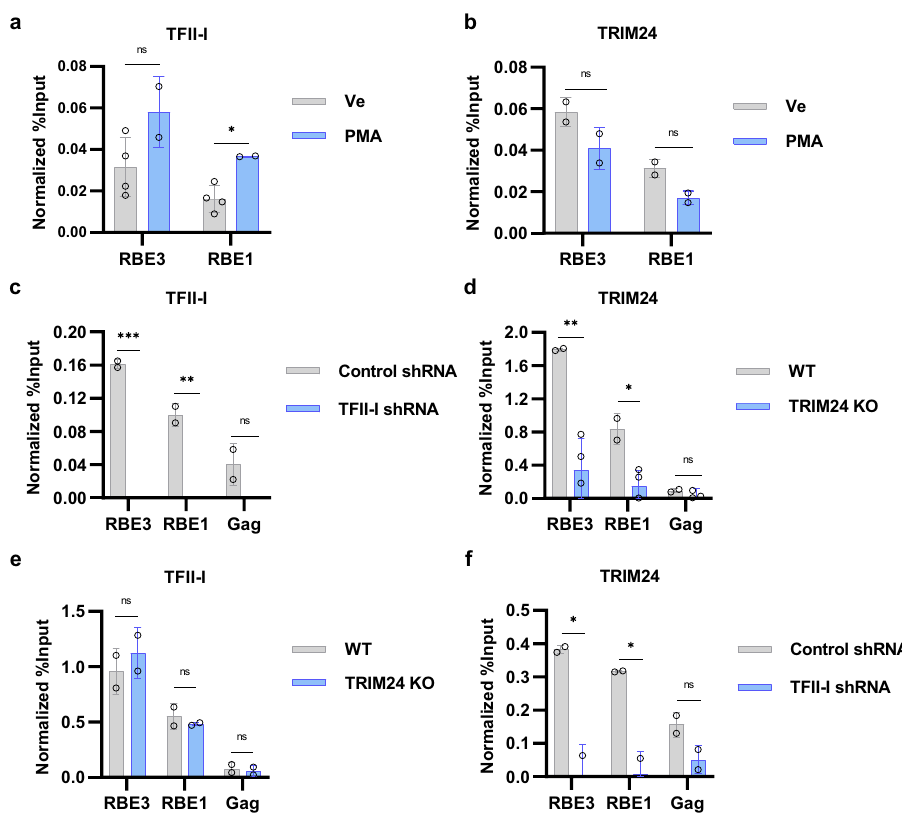
Fig. 6 TFII-I/TRIM24 co-localize to the HIV-1 LTR. a , b Jurkat Tat mdHIV Clone 11 cells were left untreated (Ve, DMSO) or incubated with 50 nM PMA for 24 h. ChIP-qPCR was performed using anti-TFII-I ( a ) or anti-TRIM24 ( b ) antibodies. c ChIP-qPCR analysis was performed using TFII-I antibodies with Jurkat mHIV-Luciferase cells transduced with pLKO lentiviral control shRNA or TFII-I targeting shRNA. d As in ( c ) but anti-TRIM24 antibodies were used for ChIP analysis. e Wild-type or TRIM24 KO Jurkat mHIV-Luciferase cells were subject to ChIP-qPCR analysis using anti-TRIM24 antibodies. f As in ( e ) but anti-TFII-I antibodies were used for ChIP analysis. ChIP-qPCR results are normalized by subtraction of values produced with sample-paired non-speci fi c IgG ( n = 2 – 4, mean ±